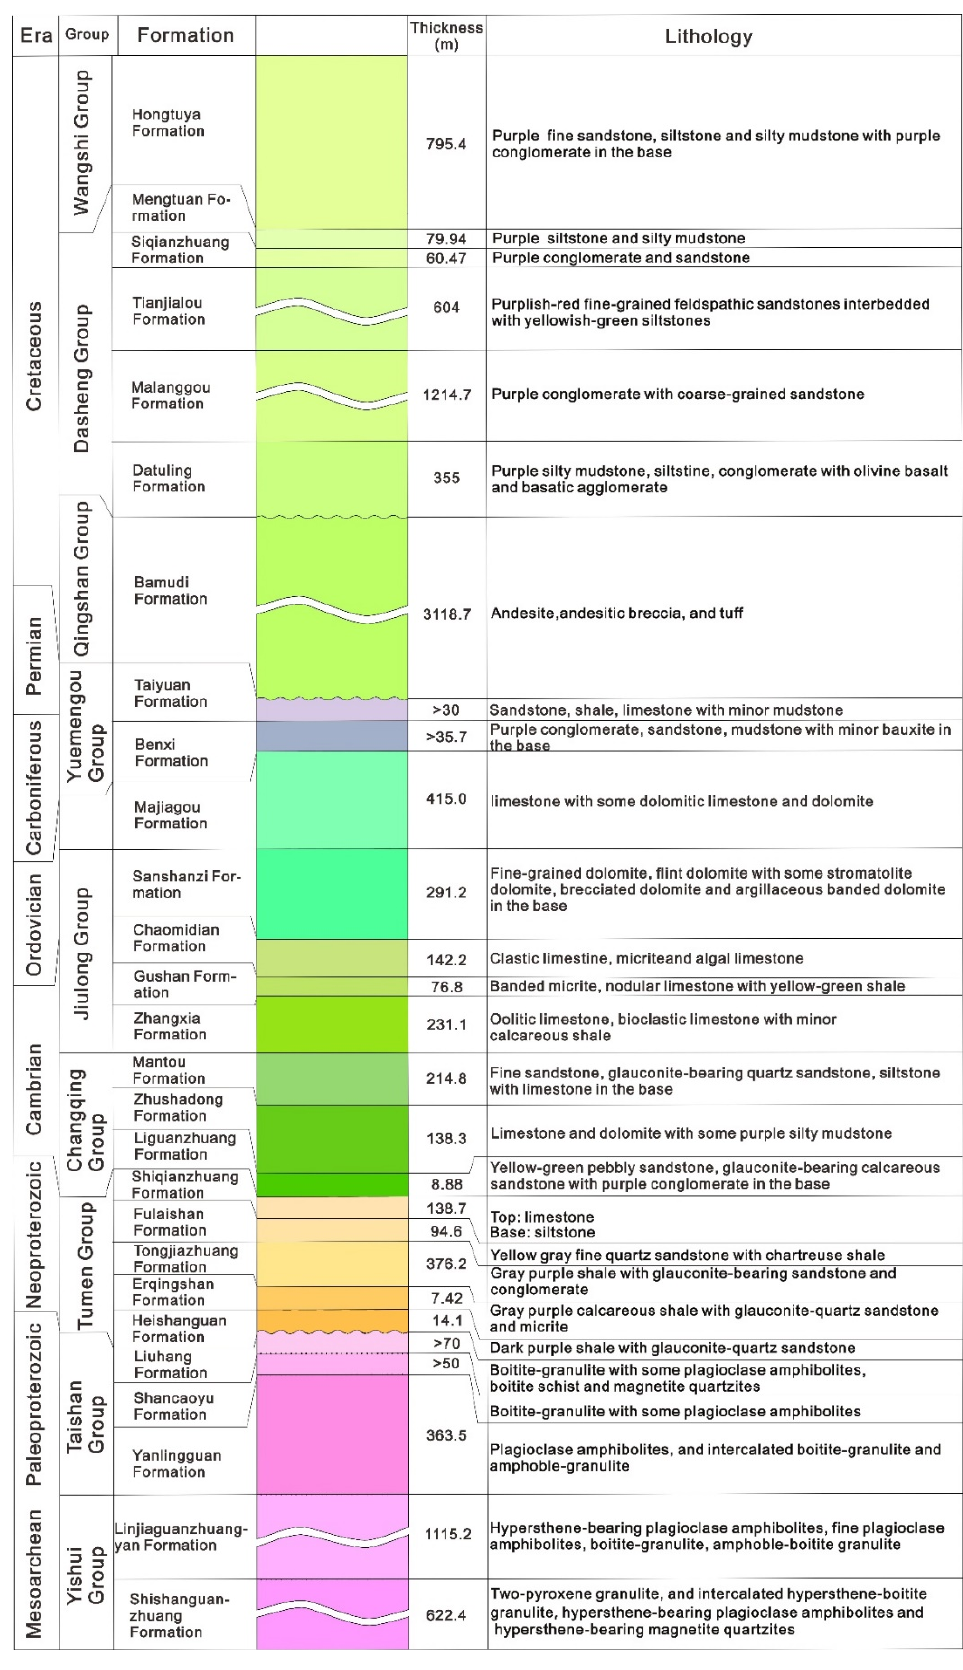
Figure 2. Summarized stratigraphic column for the Yishui region in the central Shandong Province (modified from [26]).